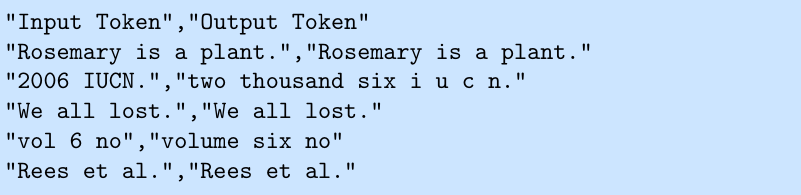
Figure 3. Sample entries from the preprocessed